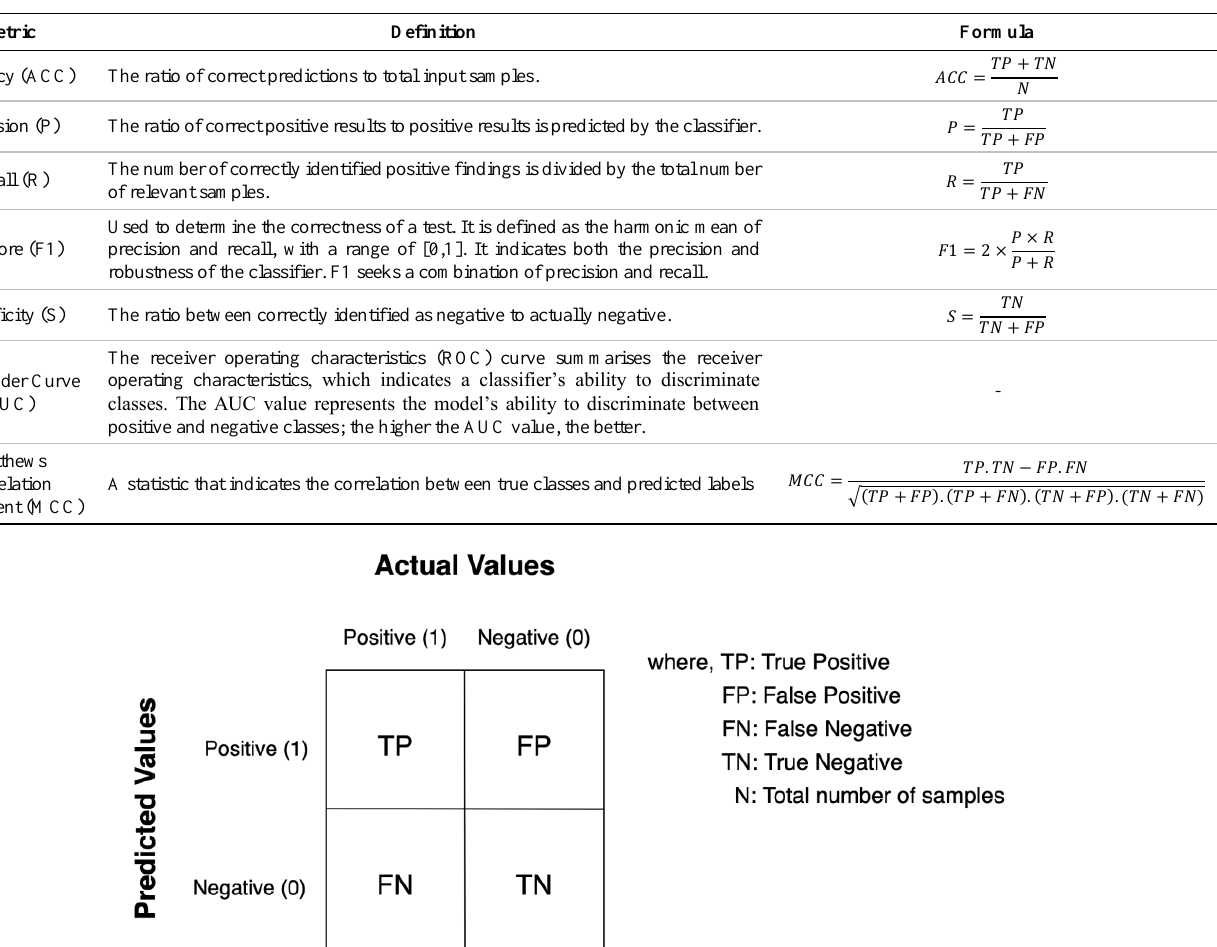
Table 5. List of evaluation measures